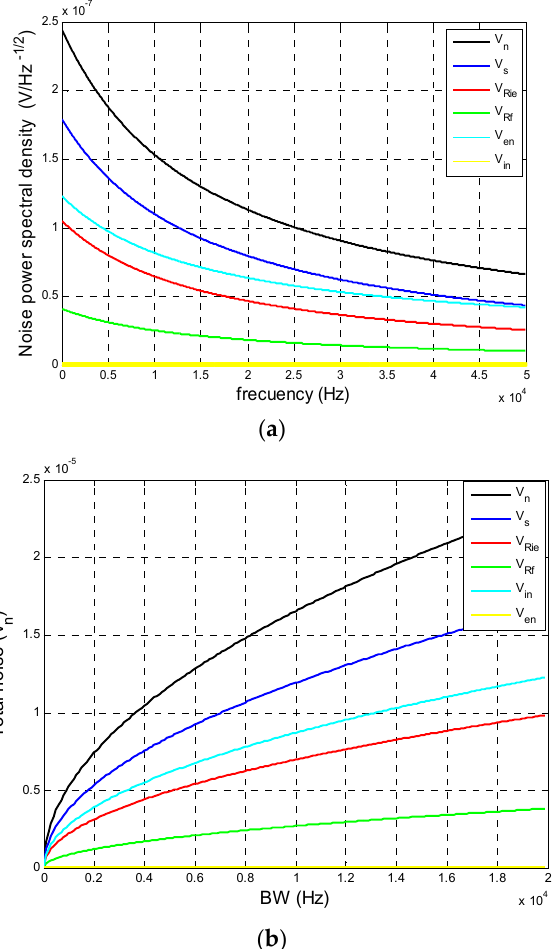
Figure 12. ( a ) Noise Power Spectral Densitiy of the conditioning circuit including the PSD and transimpedance amplifier; ( b ) Total noise at the amplifier output depending on the bandwidth of the bandpass filter.